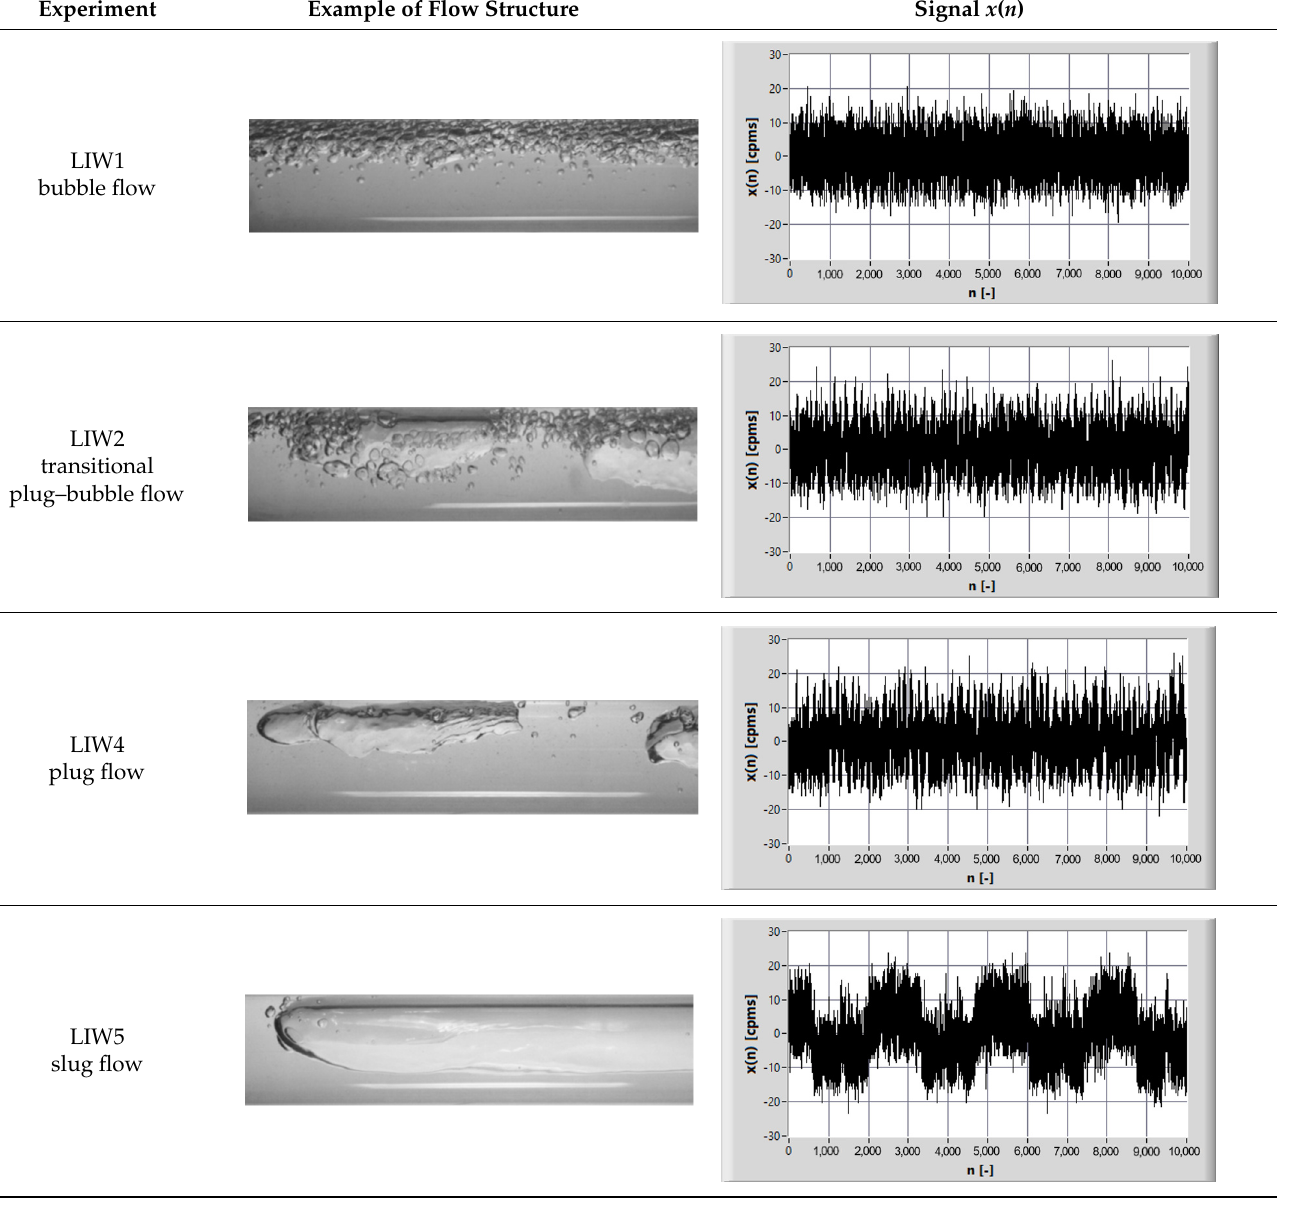
Table 1. Examples of flow structures and signals x ( n ) obtained in LIW1, LIW2, LIW4, and LIW5 experiments.